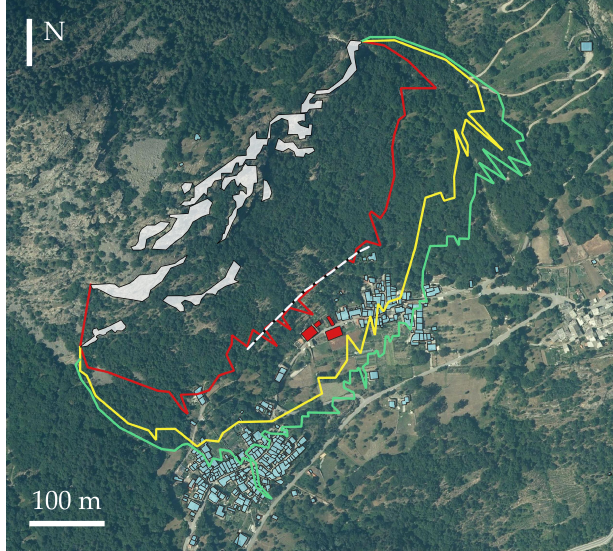
Figure 5. Maximum extent of the invasion areas obtained via the probabilistic software Rockyfor3D (red: 5 years—1.5 m 3 , yellow: 30 years—5 m 3 , green: 100 years—10 m 3